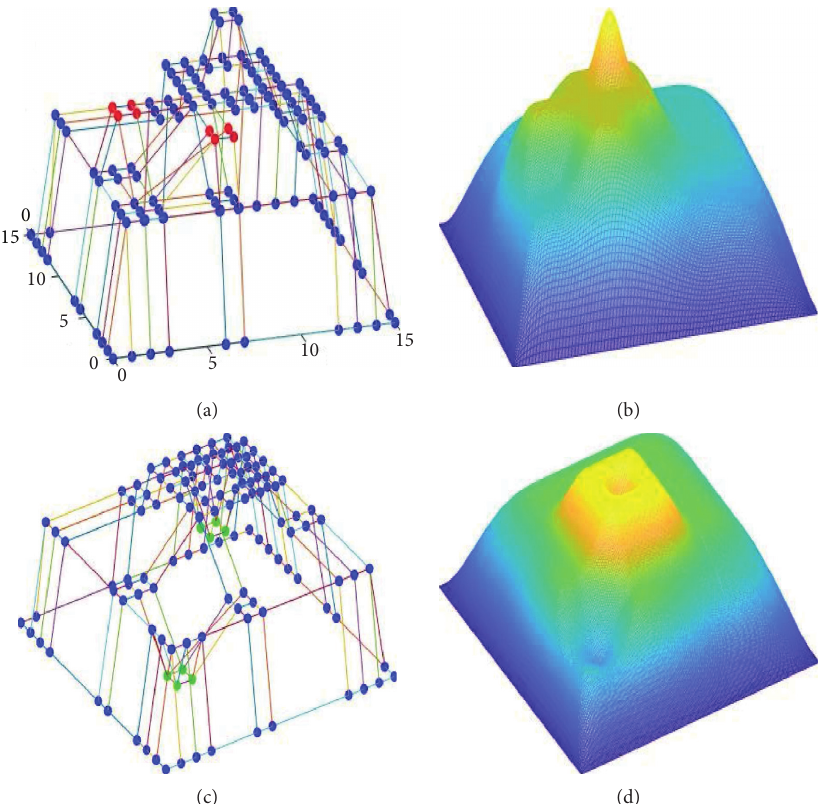
Figure 9: The index space and the control mesh. (a) Adjusting the position of the control points corresponding to the T-vertices in the Figure 5(c). (b) The surface figure obtained by adjusting the position of the control point corresponding to the T-vertices. (c) Adjusting the position of the control points corresponding to the basis vertices in the Figure 5(c). (d) The surface figure obtained by adjusting the position of the control point corresponding to the basis vertices.